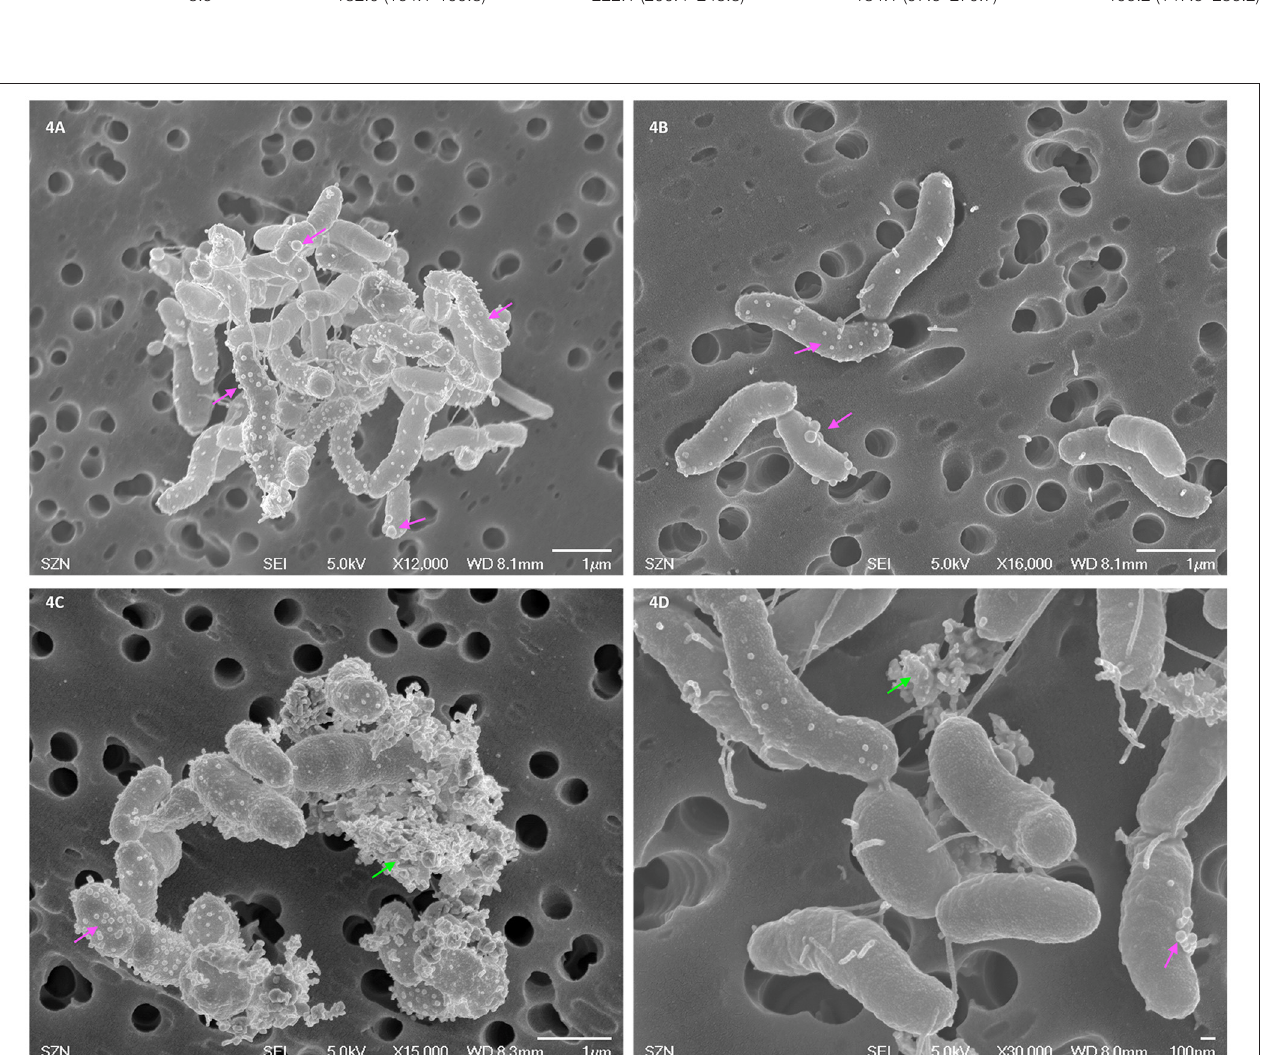
FIGURE 4 | SEM images of Vibrio anguillarum after toxicity testing exposure in 2% NaCl saline solution: control (A,B) and CuO NP dispersion (40 mg/l, C,D ). Blebs are indicated by pink arrows, nanoparticle aggregates by green arrows.